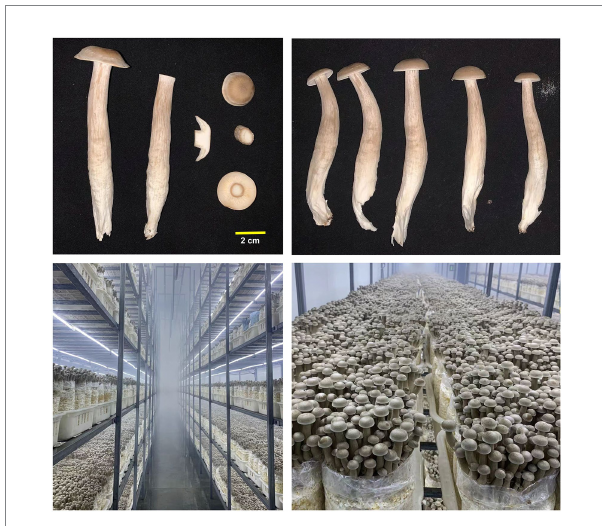
FIGURE 1 Industrially cultivated Lyophyllum decastes fruiting